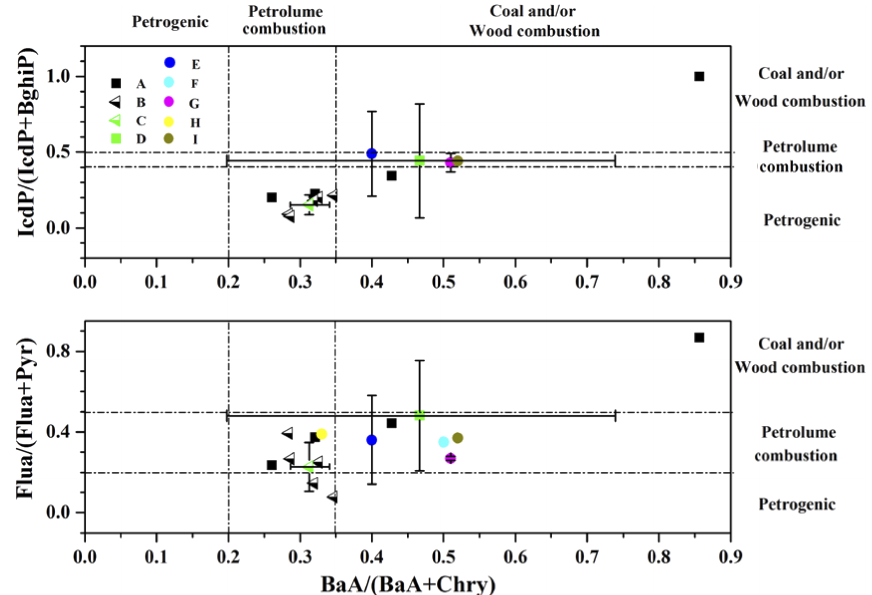
Figure 7. Cross plots for the ratios of BaA / (BaA + Chry) vs. IcdP / (IcdP + BghiP) and BaA / (BaA + Chry) vs. Flua / (Flua + Pry) and comparison with those from other diesel vehicle sources. A and B are the isomer ratios of the PAHs from the excavators and trucks, respec- tively, tested in this study; C and D are the average isomer ratios of PAHs for trucks and excavators tested in this study; E, F, G, H, and I are results obtained from Liu et al. (2015), Wang et al. (2015), Shah et al. (2005), Schauer et al. (1999), and Chen et al.